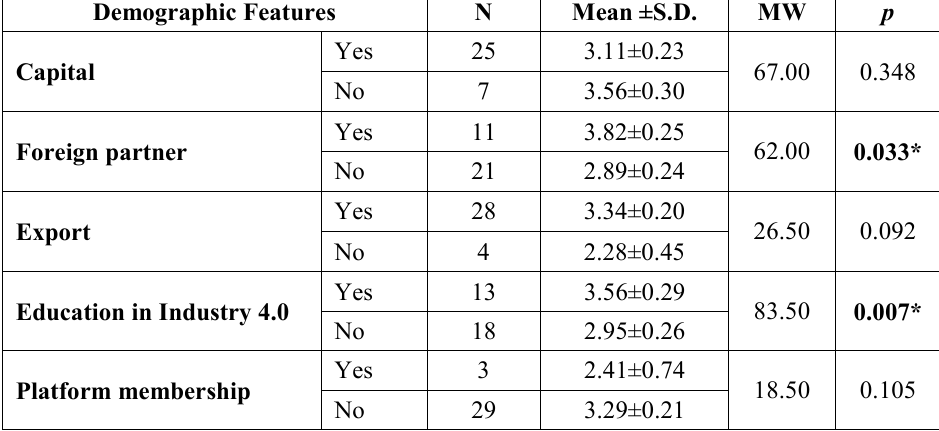
Table 4. Results of Mann Whitney U Test for Demographic Characteristics of the Enterprise Related to the Level of Education Awareness Demographic